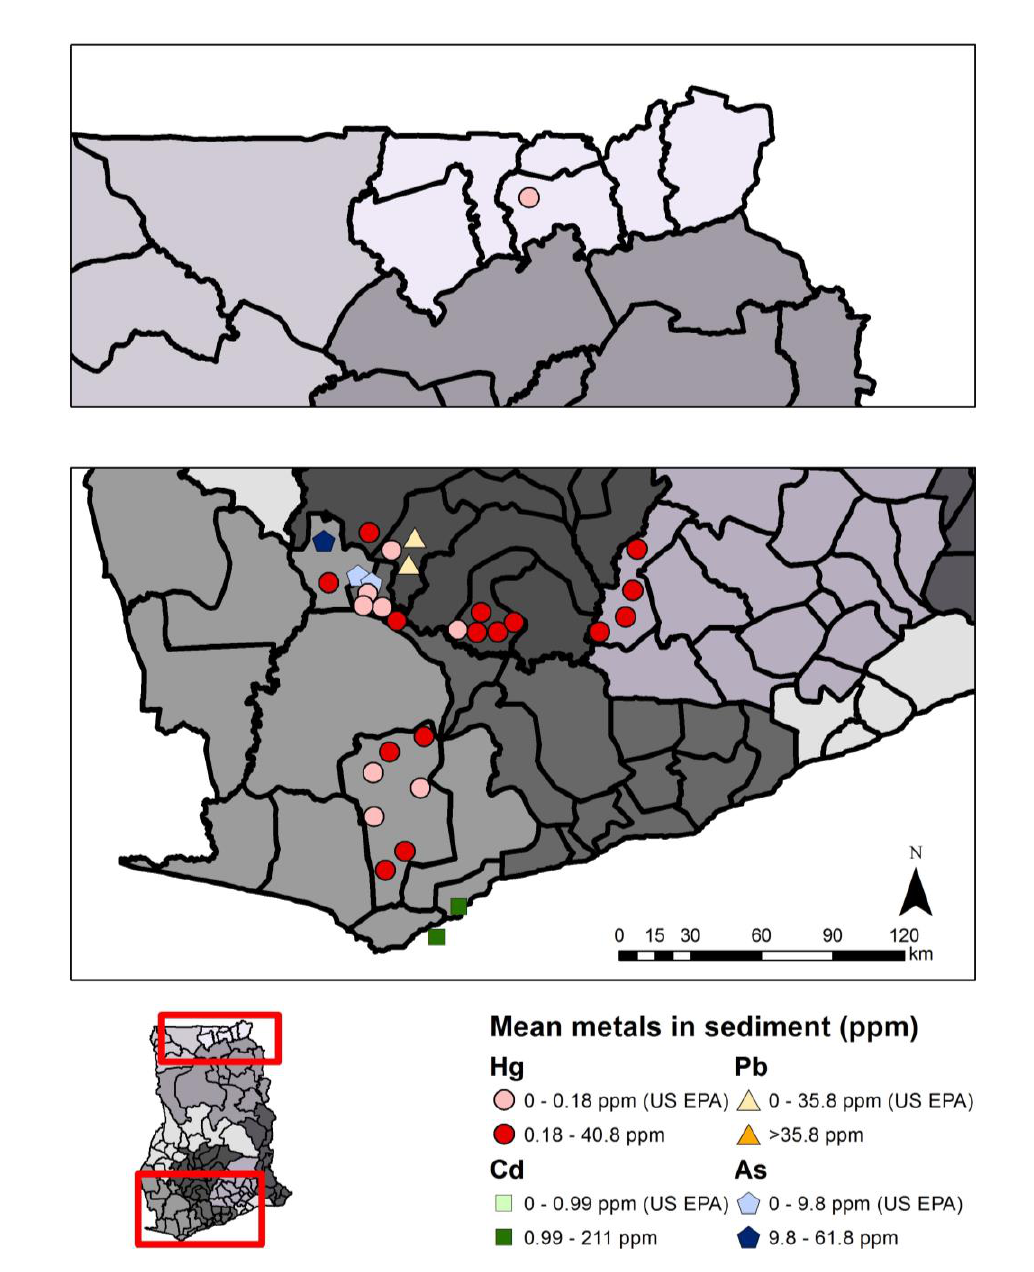
Figure 7. Metals in sediment samples in southwest (bottom panel) and northeast (upper panel) Ghana. Each symbol represents the mean metals value (µg/g or ppm) from a single study in that region, and for illustrative convenience the symbols are scattered randomly within the district where the sampling took place. Political regions are distinguished by different shades of grey. Mean total mercury (Hg), lead (Pb), cadmium (Cd), or arsenic (As) above or below guidelines are